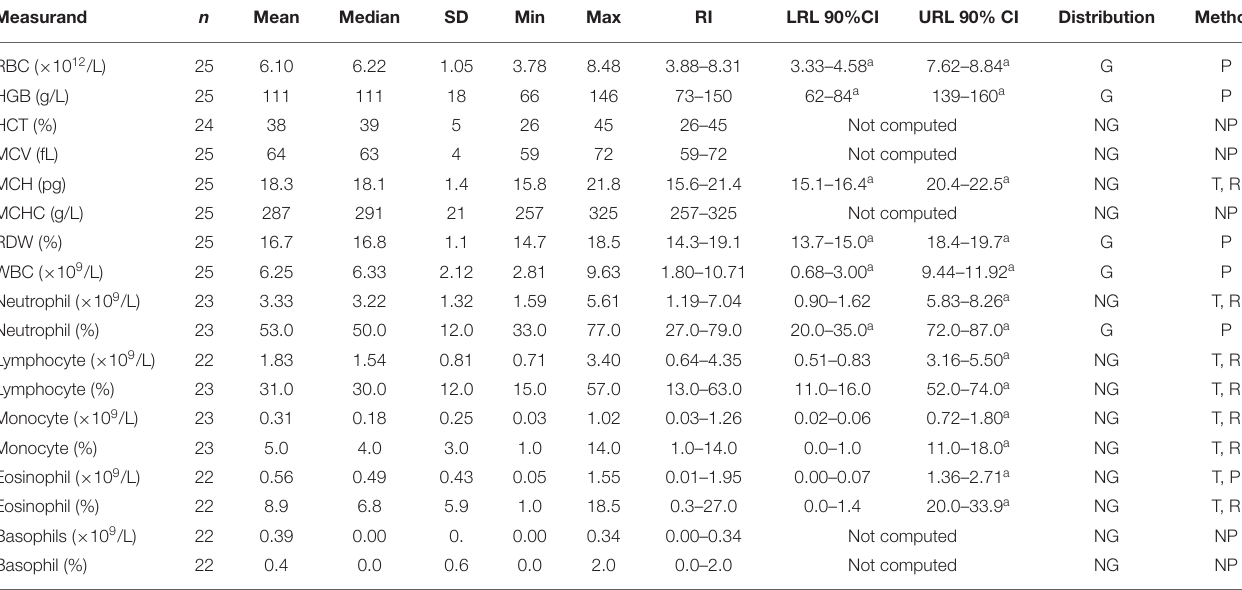
TABLE 3 | Hematology reference intervals for Temminck’s pangolin using the Abaxis HM5 hematology analyser and 200-cell manual leukocyte differential counts.